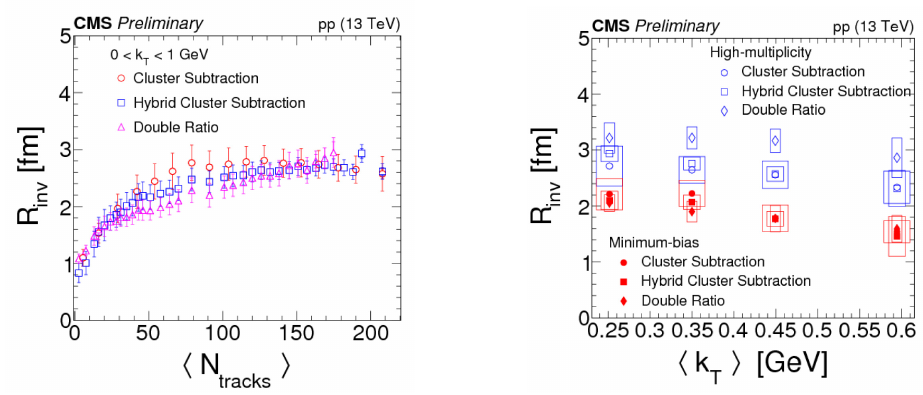
as a function of multiplicity and . In the left plot, statistical and systematical Fig. 3. Results for uncertainties are represented by internal and external error bars, respectively. In the right plot, statistical 𝑅𝑅 𝑜𝑜𝑜𝑜𝑖𝑖 𝑘𝑘 𝑇𝑇 and systematic uncertainties are shown as error bars and open boxes, respectively [4].